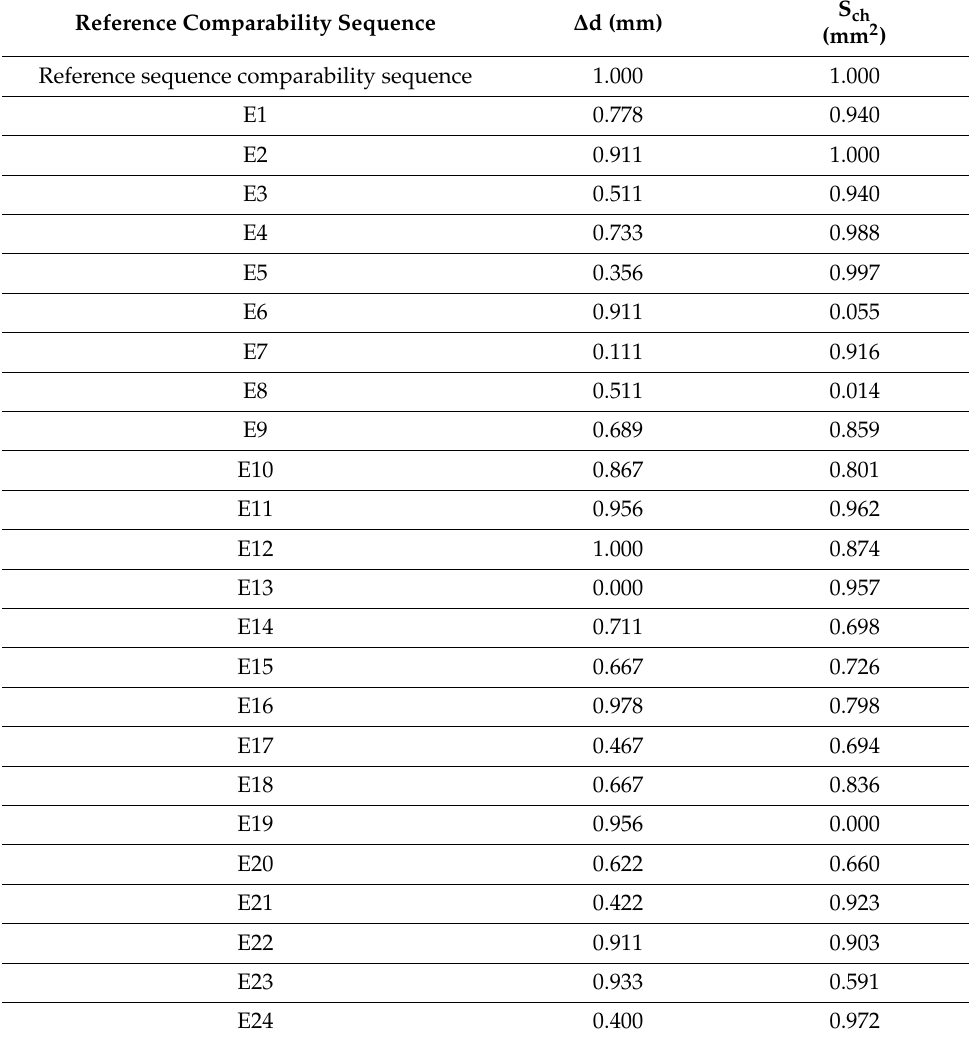
Table 6. The sequence after data